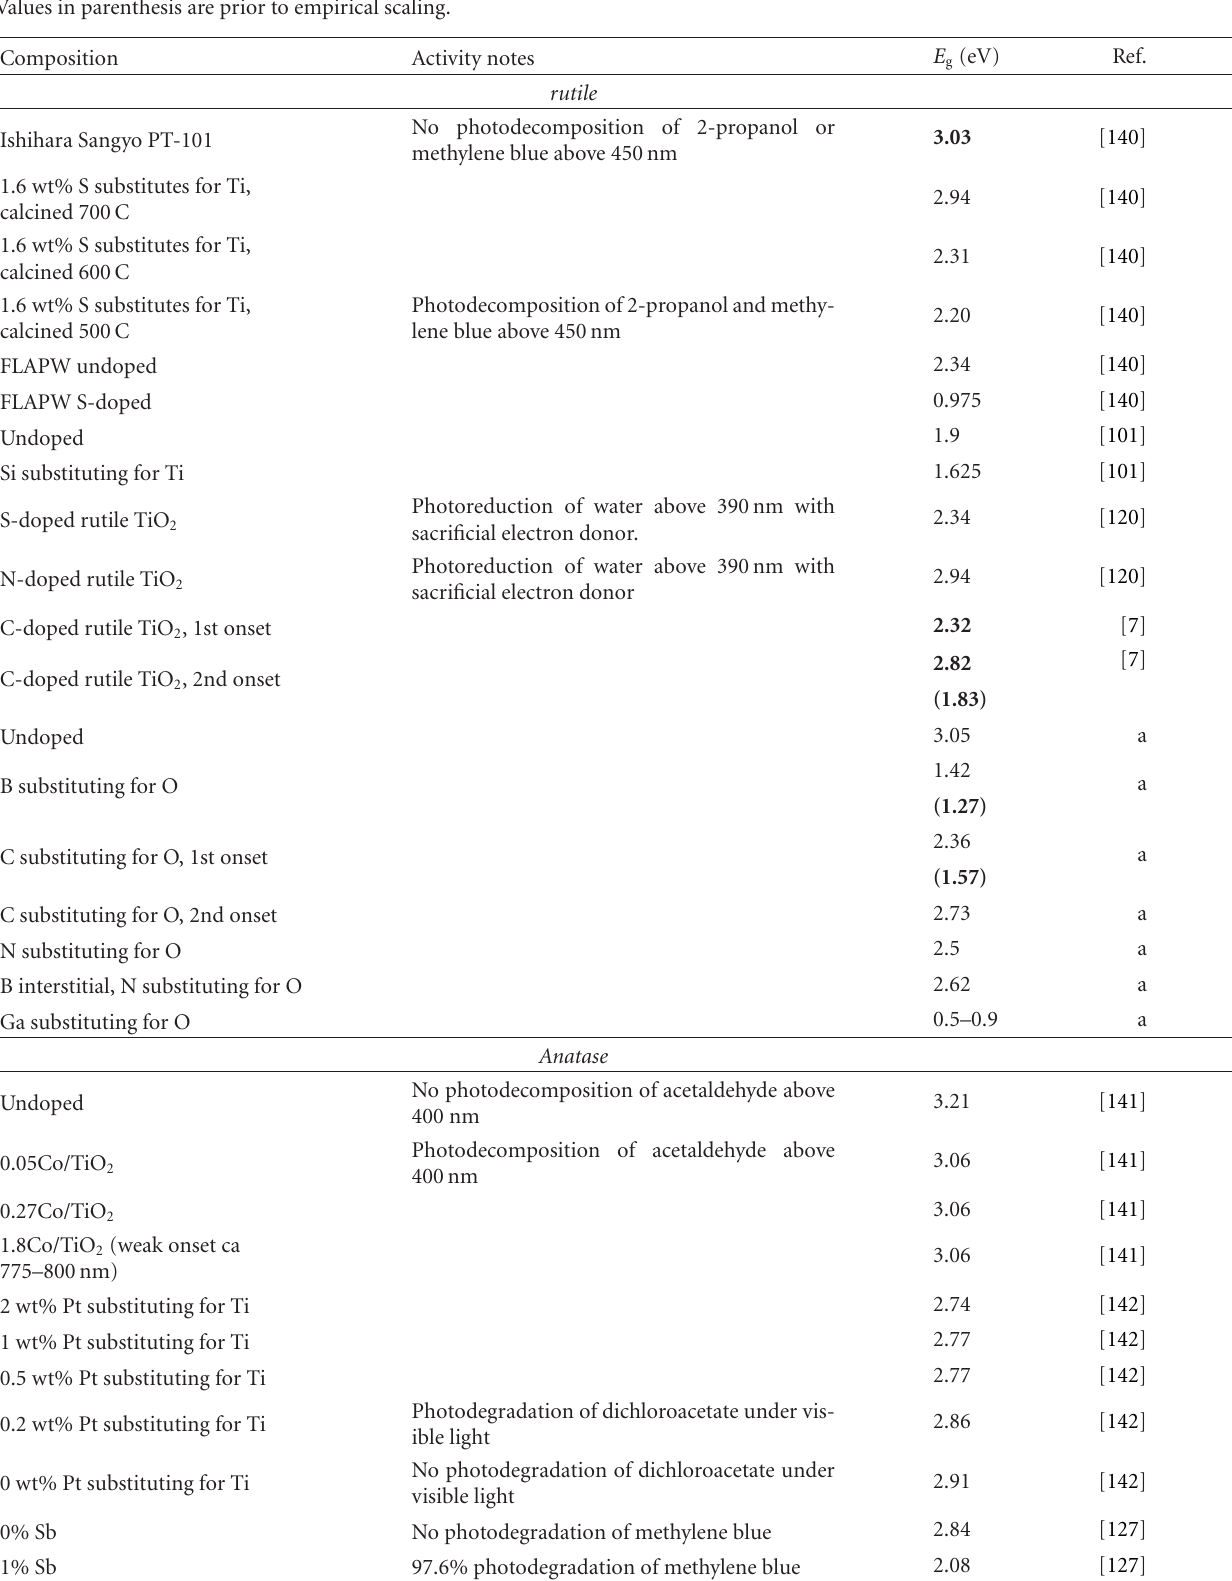
Table 4: Comparison of experimental and computed absorption onsets with notes about photocatalytic activity. Since direct comparison of improvements in catalytic e ffi ciency between catalysts is di ffi cult unless the same test reactions are used, quantitative notes about photocatalytic activity are relative to other measurements reported in the same reference. Values used in fitting (6) are shown in boldface. Values in parenthesis are prior to empirical